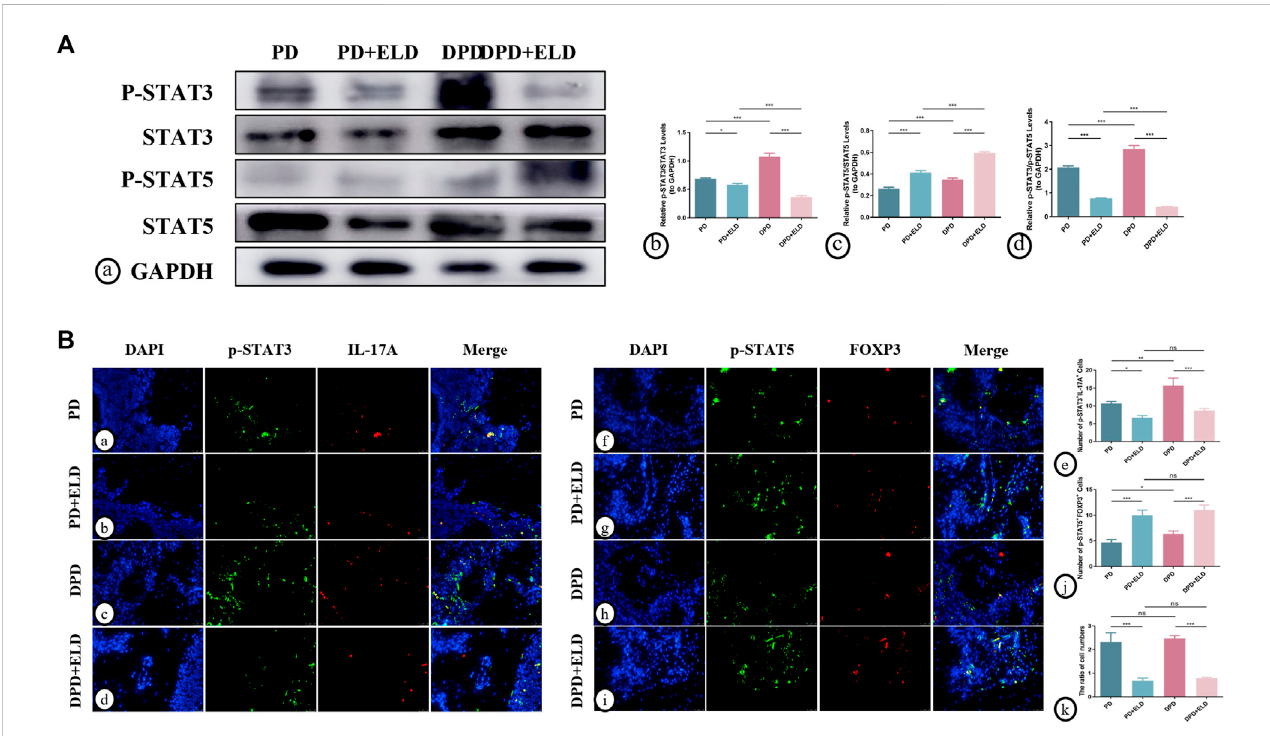
FIGURE 7 ELDregulatedTh17/TregcellsthroughtheSTAT3/STAT5signal. (A) (a)Theproteinexpression ofp-STAT3, STAT3,p-STAT5, STAT5andGAPDHdetected by western blotting in the PD, PD + ELD, DPD and DPD + ELD groups. The statistical analysis of (b) p-STAT3/STAT3, (c) p-STAT5/STAT5 and (d) the ratio of p-STAT3/p-STAT5 in western blotting. (B) The representative immuno fl uorescence staining images of p-STAT3 + IL-17A + cells in the (a) PD, (b) PD + ELD, (c) DPD and (d) DPD + ELD groups. (e) The statistical analysis of p-STAT3 + IL-17A + cell counts. The representative immuno fl uorescence staining images of p-STAT5 + FOXP3 + cells in the (f) PD, (g) PD + ELD, (h) DPD and (i) DPD + ELD groups. (j) The statistical analysis of p-STAT5 + FOXP3 + cell counts. (k) The ratio of p-STAT3 + IL-17A + /p-STAT5 + FOXP3 + cells. Data were shown as mean ± SD (* p < 0.05. ** p < 0.01. *** p <